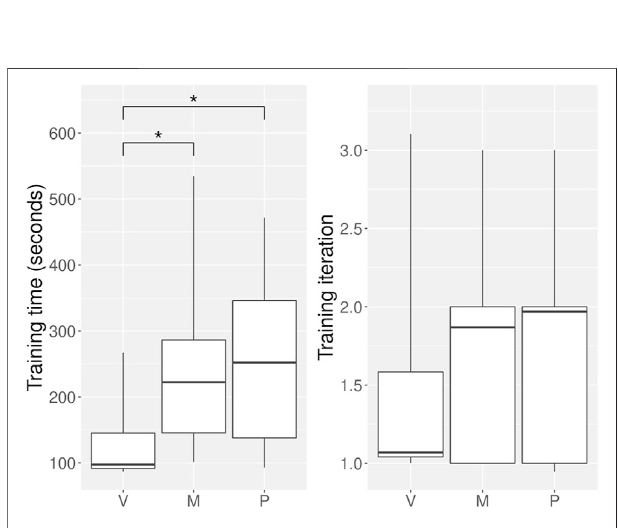
FIGURE 7 | Training times and iterations for each experimental condition. *means signi fi cant difference ( p <